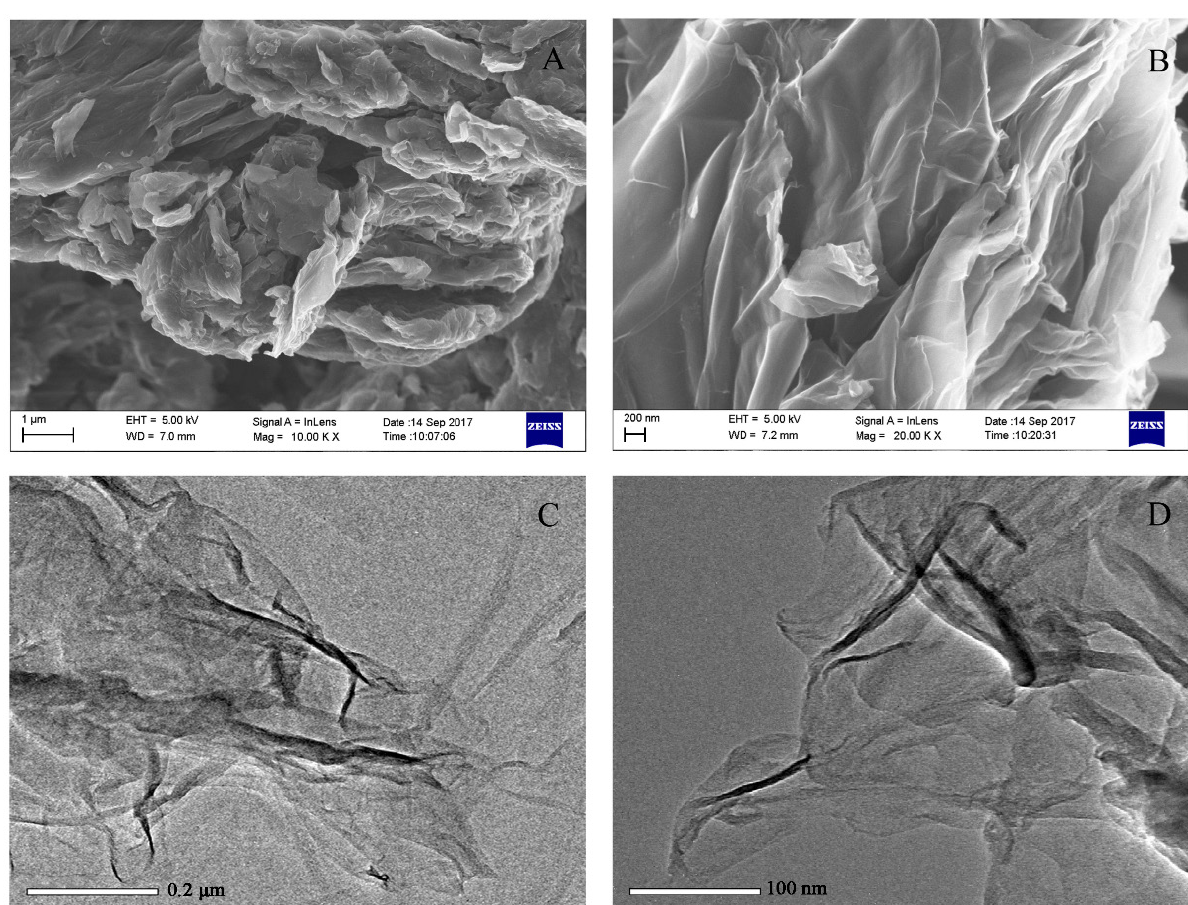
; TEM images of (C) GO and (D) GO-NH 2